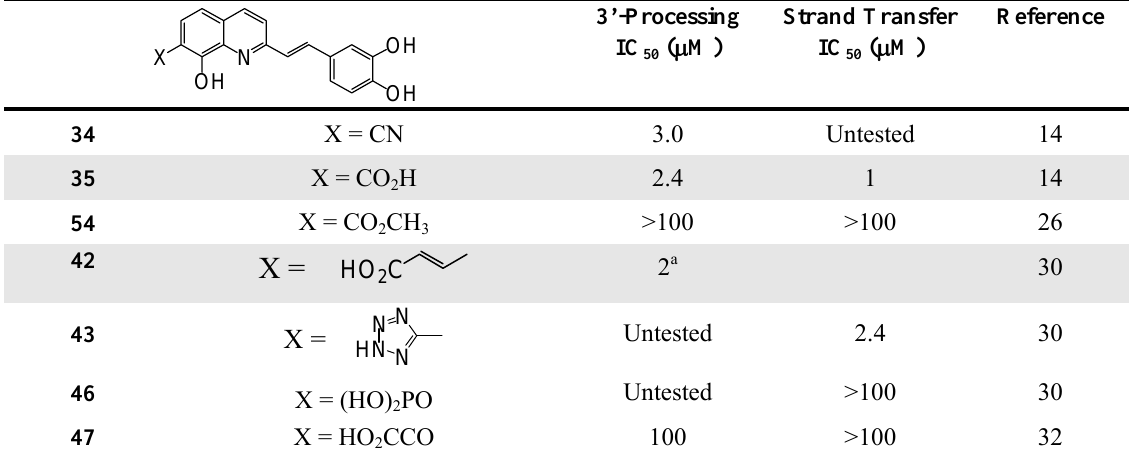
Table 3. HIV-1 IN inhibitory potency of various 7-substituted